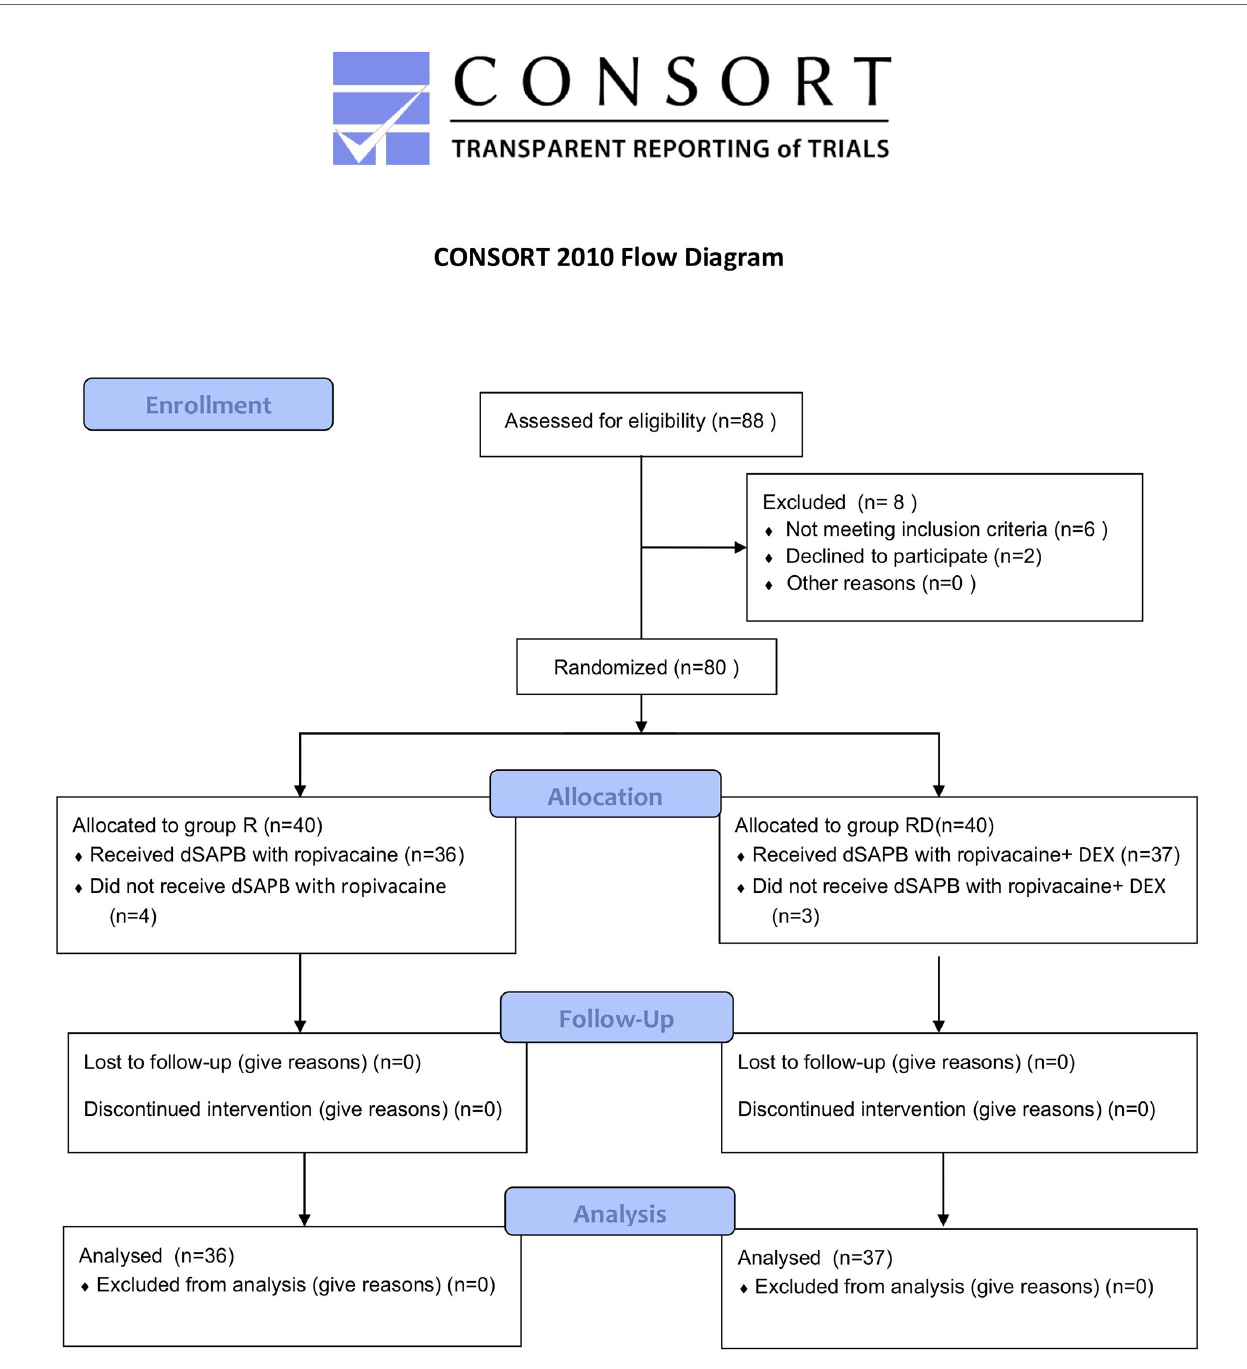
FIGURE 1 | CONSORT 2010 fl ow